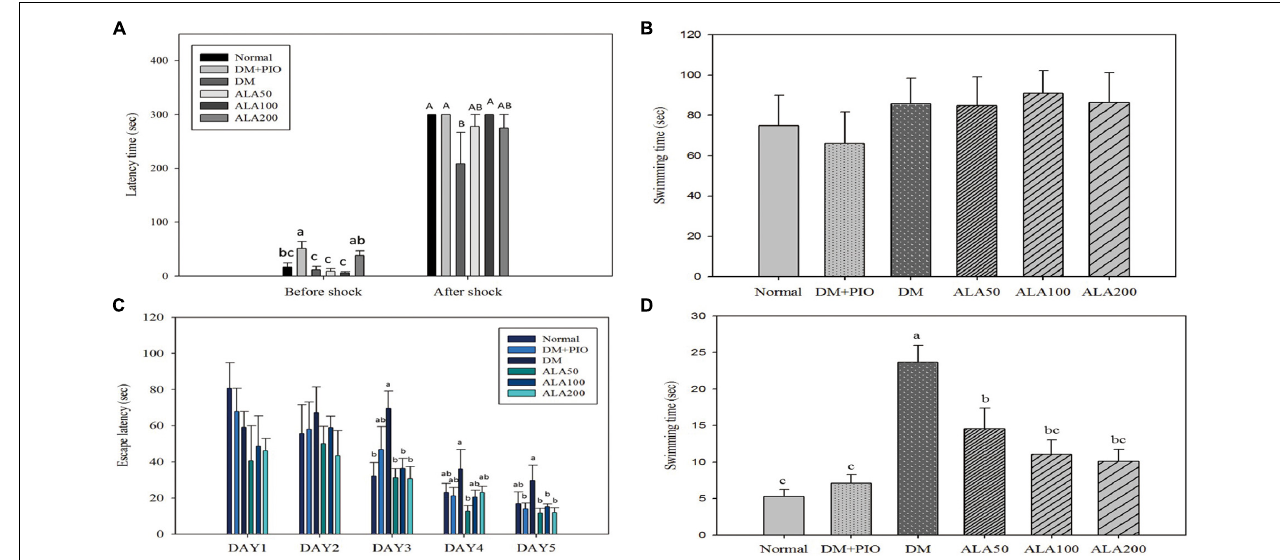
FIGURE 1 | Passive avoidance test (A) , physical function (B) , spatial acquisition (C) , and probe trial (D) of Morris Water Maze of high-fat diet and streptozotocin-induced type 2 diabetic rats treated with alpha-lipoic acid for 13 weeks. Normal, Normal diet; DM, high-fat diet (HFD; 60% fat) with STZ (30 mg/kg body weight, i.p.) induced diabetic rats; DM + Pio, DM rats gavaged with pioglitazone (30 mg/kg body weight) for 13 weeks; DM + ALA50, DM rats gavaged with ALA (50 mg/kg body weight) for 13 weeks; DM + ALA100, DM rats gavaged with ALA (100 mg/kg body weight) for 13 weeks; DM + ALA200, DM rats gavaged with ALA (200 mg/kg body weight) for 13 weeks. Values were calculated as the mean ± SEM, n = 6 for each group. a–c letter is significantly different among all samples tested before the shock of the passive avoidance test or Morris Water Maze test ( p < 0.05). A,B letter is significantly different among all samples tested in after shock of passive avoidance test ( p <